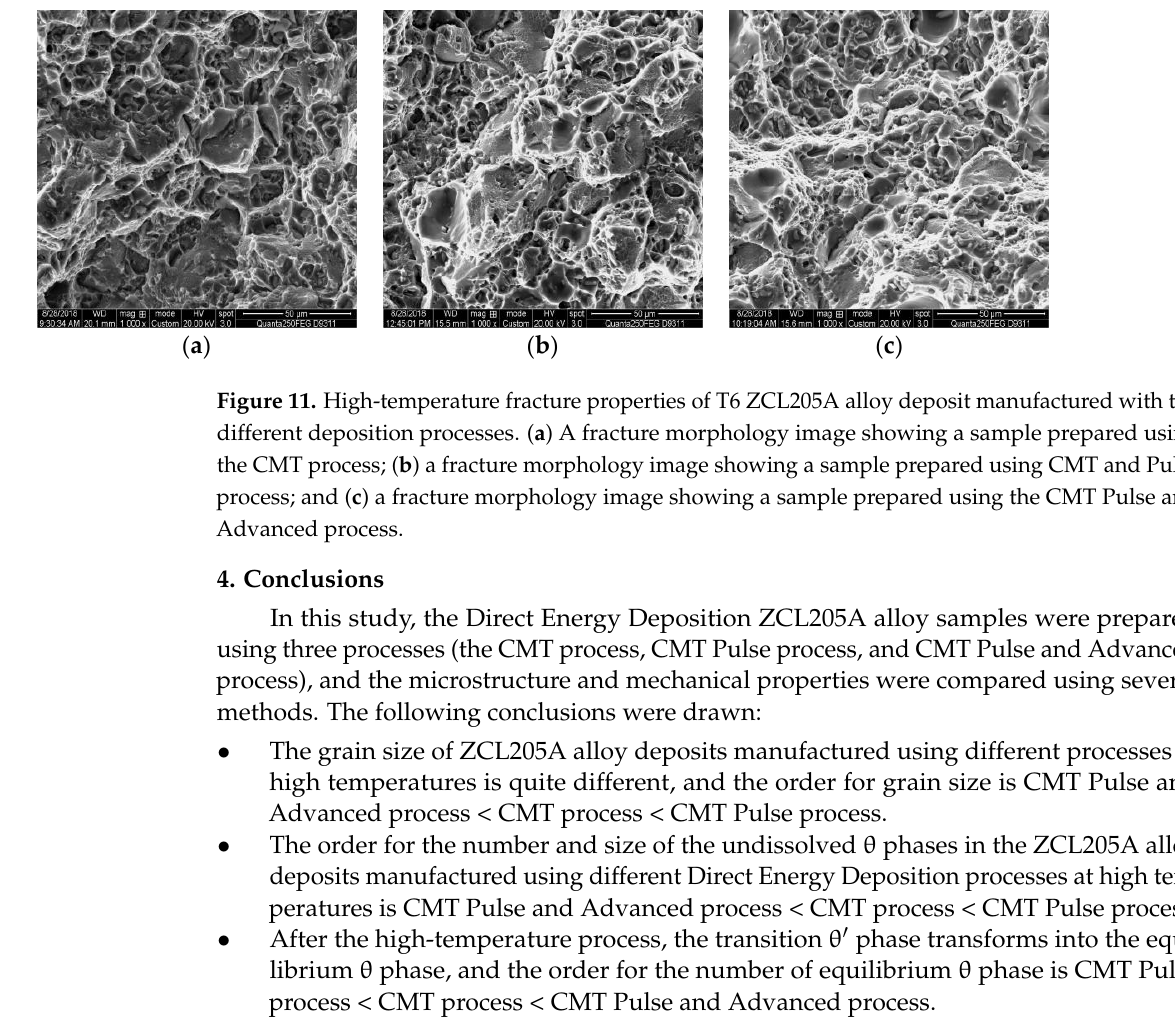
11 of 13 Figure 10. High-temperature mechanical properties of ZCL205A alloy deposited using different deposition processes. 3.6. Fracture Morphology The high-temperature (200 °C for 30 min) fracture morphology images of the Direct Energy Deposition ZCL205A alloy manufactured using different deposition processes are shown in Figure 11. The fracture surface on the ZCL205A alloy deposited using the CMT process contains dimples and dissociation surfaces. The two structures each account for 50% of the area, indicating that the fracture mode of the alloy is a mixed fracture. The